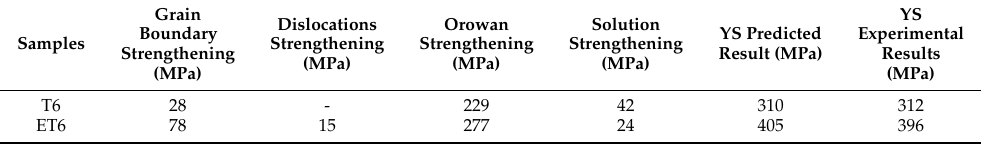
Table 4. The calculated strengthening contributions (MPa) in the T6 and ET6 alloys.